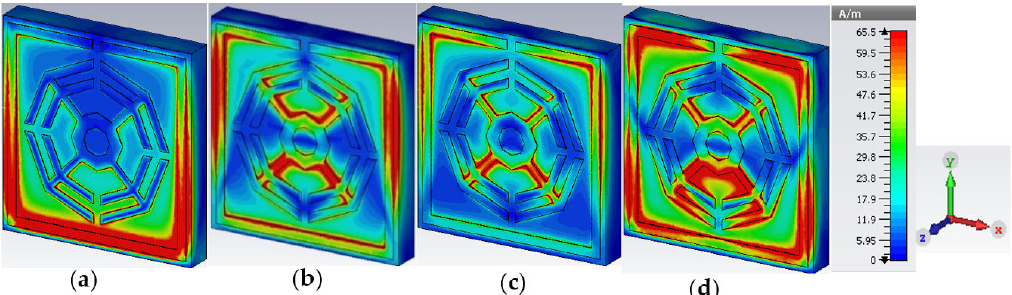
Figure 9. Magnetic field distribution at ( a ) 2.35 GHz ( b ) 7.72 GHz ( c ) 9.23 GHz and ( d ) 10.68 GHz.